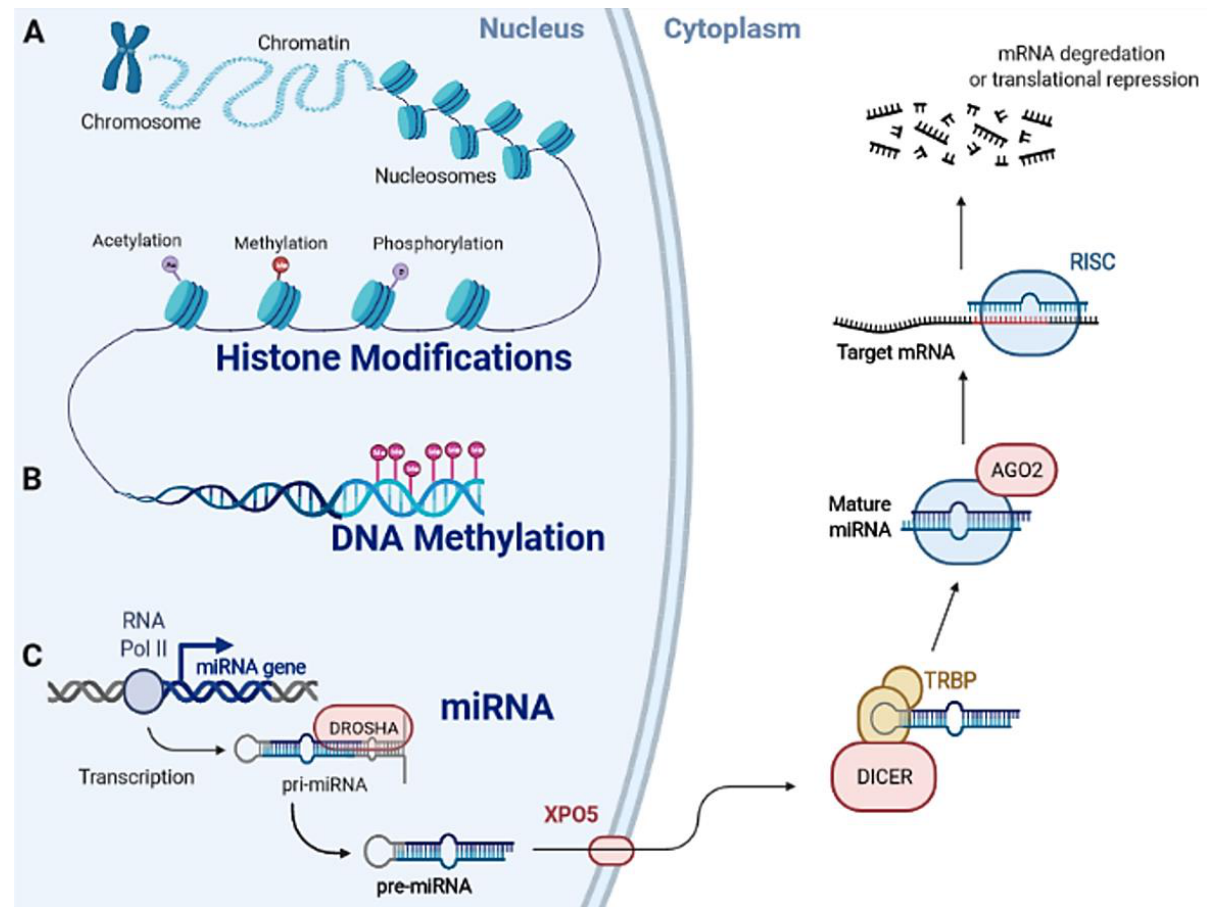
Figure 1. Epigenetic mechanisms. Epigenetic mechanisms comprise ( A ) histone posttranslational modifications (HPTMs), ( B ) DNA methylation, and ( C ) microRNAs (miRNAs) regulation. Gene expression can be regulated before transcription initiation by HPTMs and DNA methylation. Both mechanisms induce a remodeling of the chromatin structure, thereby making genes either less or more accessible for transcription factors, according to the different epigenetic modifications. Unlike DNA methylation and HPTMs, miRNAs regulate the expression of genes at the post-transcriptional level. miRNAs negatively regulate genes through complementing their mRNAs, which results in mRNA degradation or translational